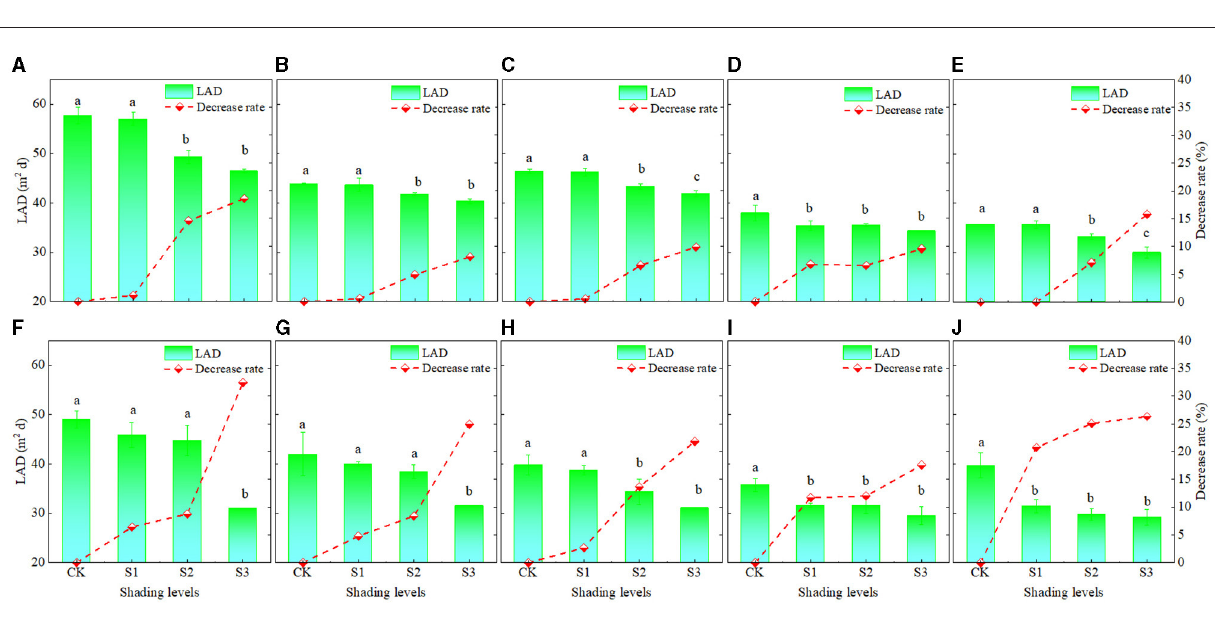
FIGURE 4 | The leaf area duration (LAD) and after silking under different shading levels and planting densities treatments and the decrease rate in LAD under each shading treatment compared to the CK. (A–E) show the cultivar XY335 results at densities D1, D2, D3, D4, and D5, respectively, and (F–J) show the ZD958 results at the same densities. See Figure 1 for planting density and shading treatment definitions. Different lowercase letters of the same cultivar above the columns show significant differences between each shading treatment for each planting density at P <